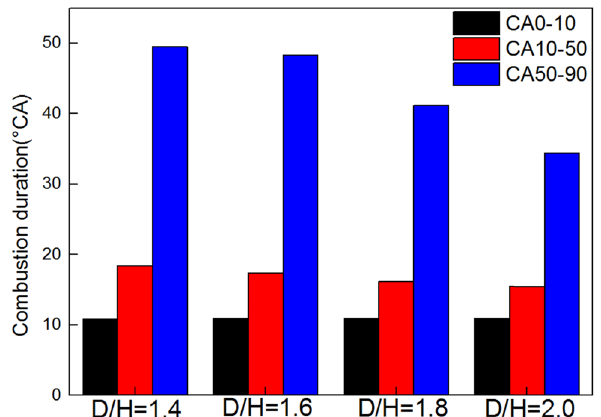
Figure 15: Combustion durations for di ff erent diameter - to - depth